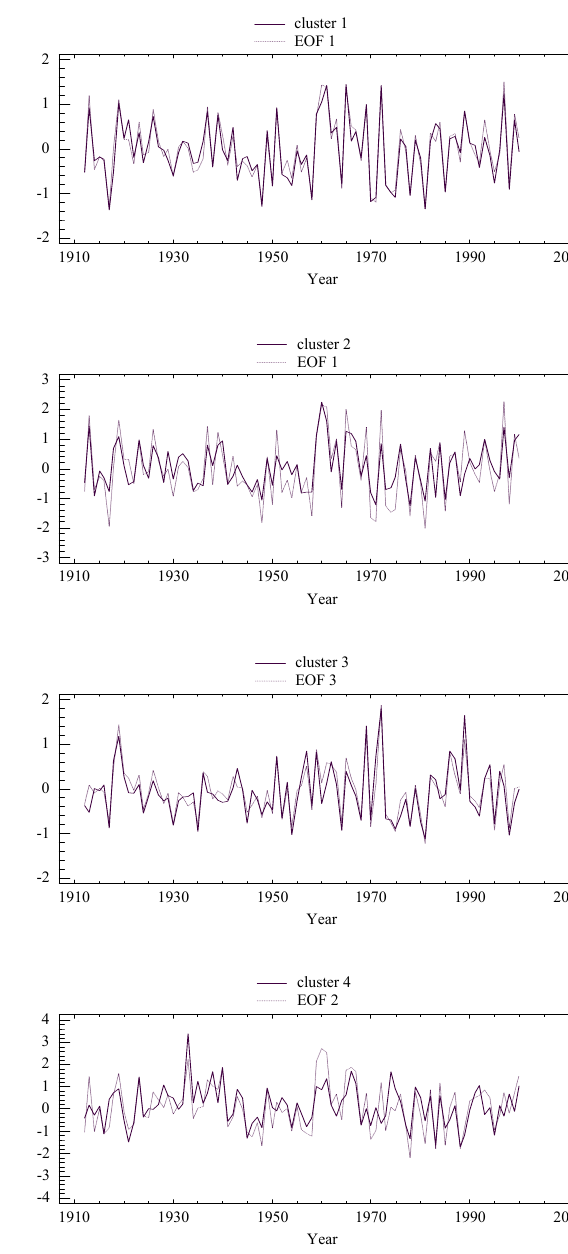
while in PCA each of the principal component is a sort of weighted average of the original data. As a result, the range of centroid series is less. However, the main result is the great similarity of series, showing identical distribution of positive and negative anomalies.